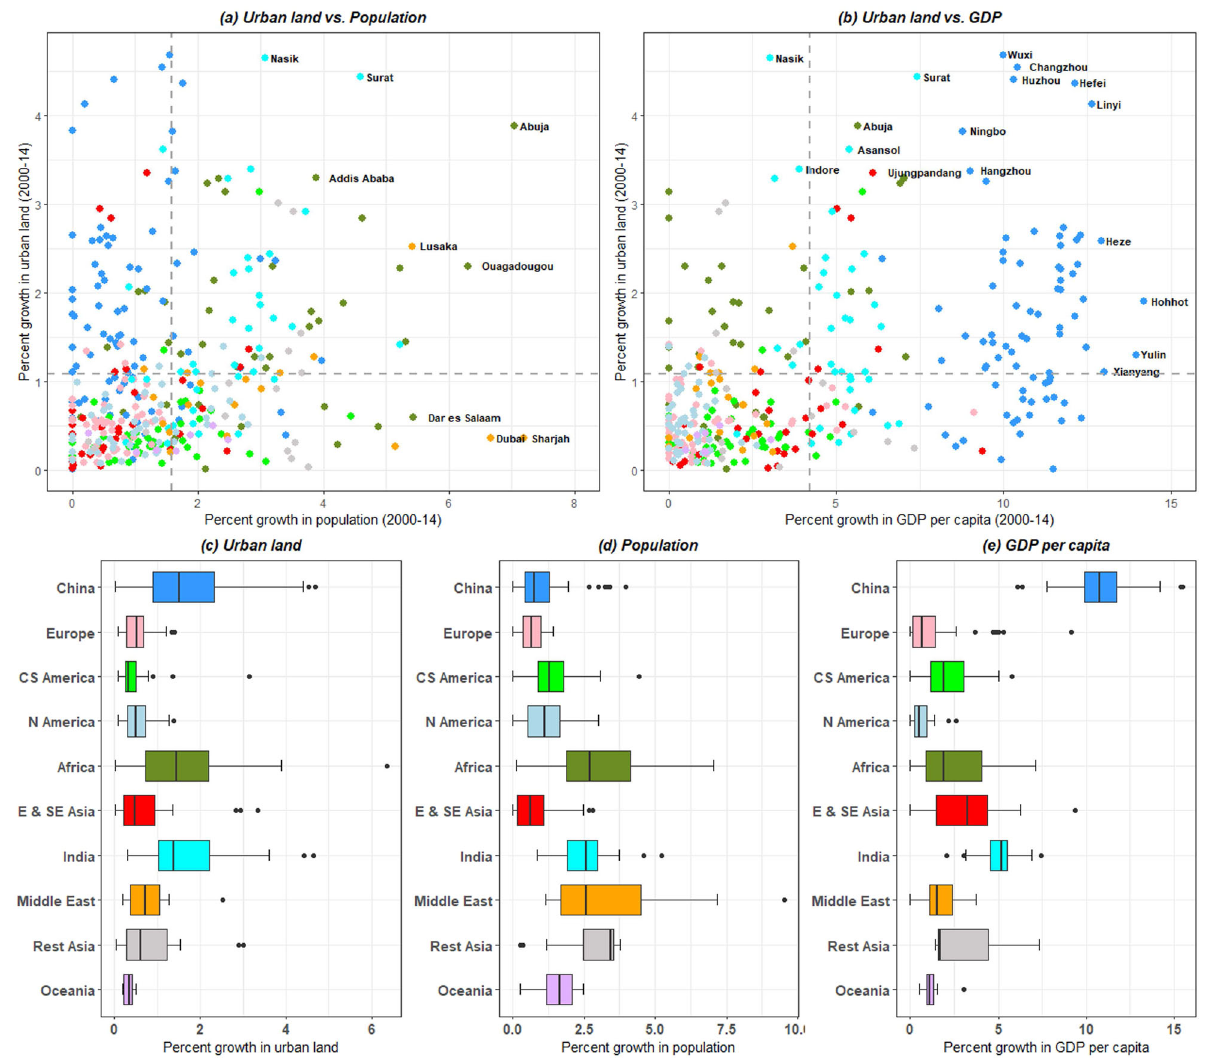
Fig. 1 Percent growth in ULE, population, and GDP for 363 cities (2000 – 2014). Regional variations in percent growth of a ULE with population, b ULE with economic growth (vertical dotted line shows mean percent growth in population/GDP per capita and horizontal dotted line shows mean percent growth in urban land), c ULE, d population, and e GDP per capita (Box plots represents 1st and 3rd quartiles, median and outliers). Regional color coding is consistent in scatterplots and boxplots. Percent growth in urban land area have been calculated from Mahtta et al. 37 . Population and GDP per capita growth rates have been calculated from the Oxford Economics 2016 database 48 . Note: The trends for the pre-2000 period are not shown due to the data unavailability of GDP at (Table 1, Model II – V). We expand on the interpretation of the R 2 statistic in the Supplementary Note 2. Even after controlling for regional dummies, GDP per capita and population variables can only explain about 40% of the variation in ULE at the city scale.